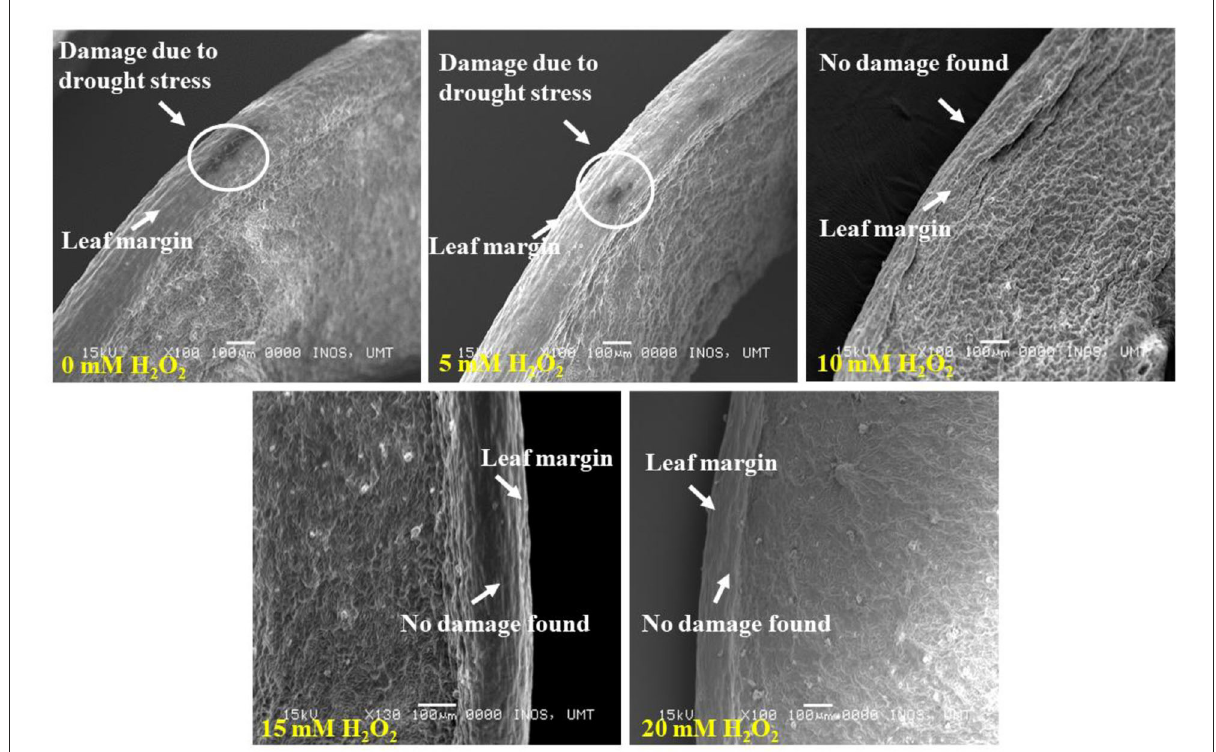
FIGURE5 SEM photographs showing the leaf margin of F. deltoidea plants. Damaged appeared in the leaf margin of the control and 5mM H 2 O 2 treated plants. No damage was found in the 10–20mM H 2 O 2 treated plants and it is proven that exogenous H 2 O 2 can protect leaf structure from oxidative damage induced by drought